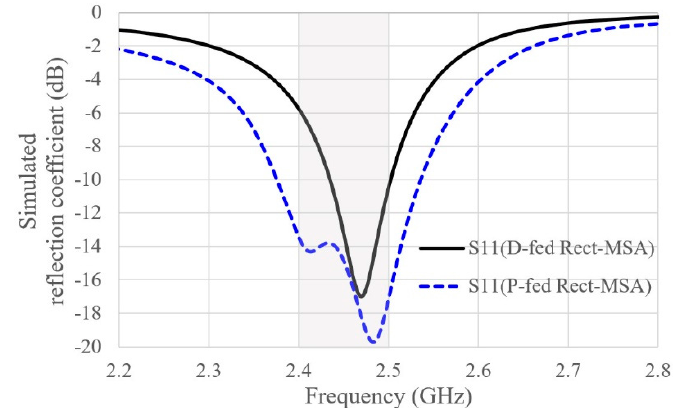
Figure 2. Simulated reflection coefficient of D-fed (direct-fed) Rect-MSA and P-fed (proximity-fed) Rect-MSA ( g = 0.5 mm, l a = 27 mm).